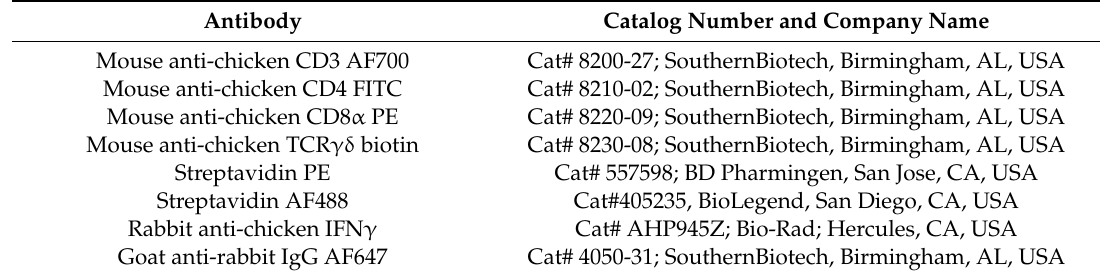
Table 2. Antibodies used for lymphocyte cell surface and intracellular IFN γ immunostaining.